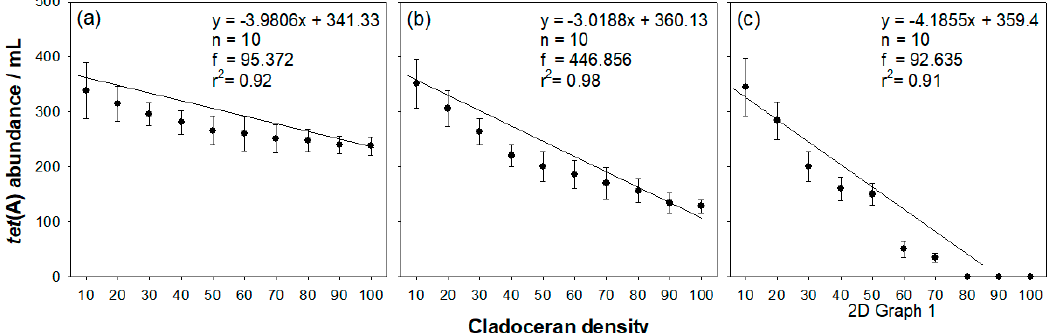
Figure 3. The relationship between cladoceran density and tet (A) abundance in water (regression df = 1, residual df = 8): ( a ) Daphnia obtusa and tet (A) abundance; ( b ) Simocephalus vetulus and tet (A) abundance; and ( c ) Cydorus sphaericus and tet (A) abundance.